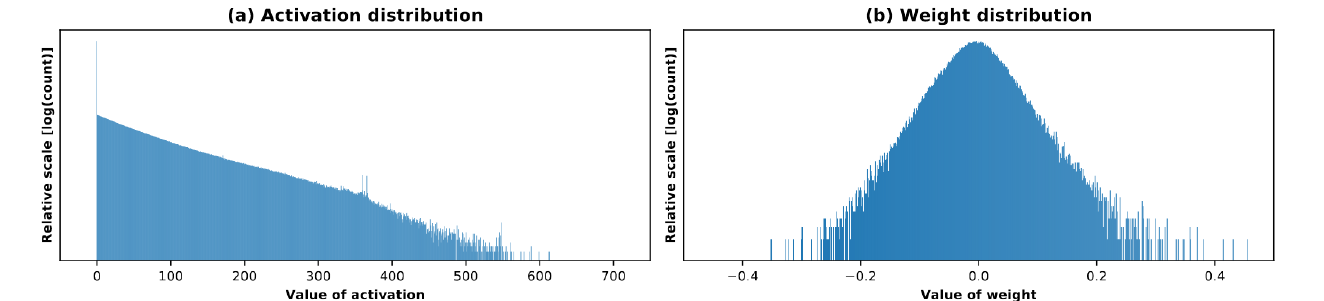
Figure 4. Activation and weight distribution of the second layer of GoogleNet (image from